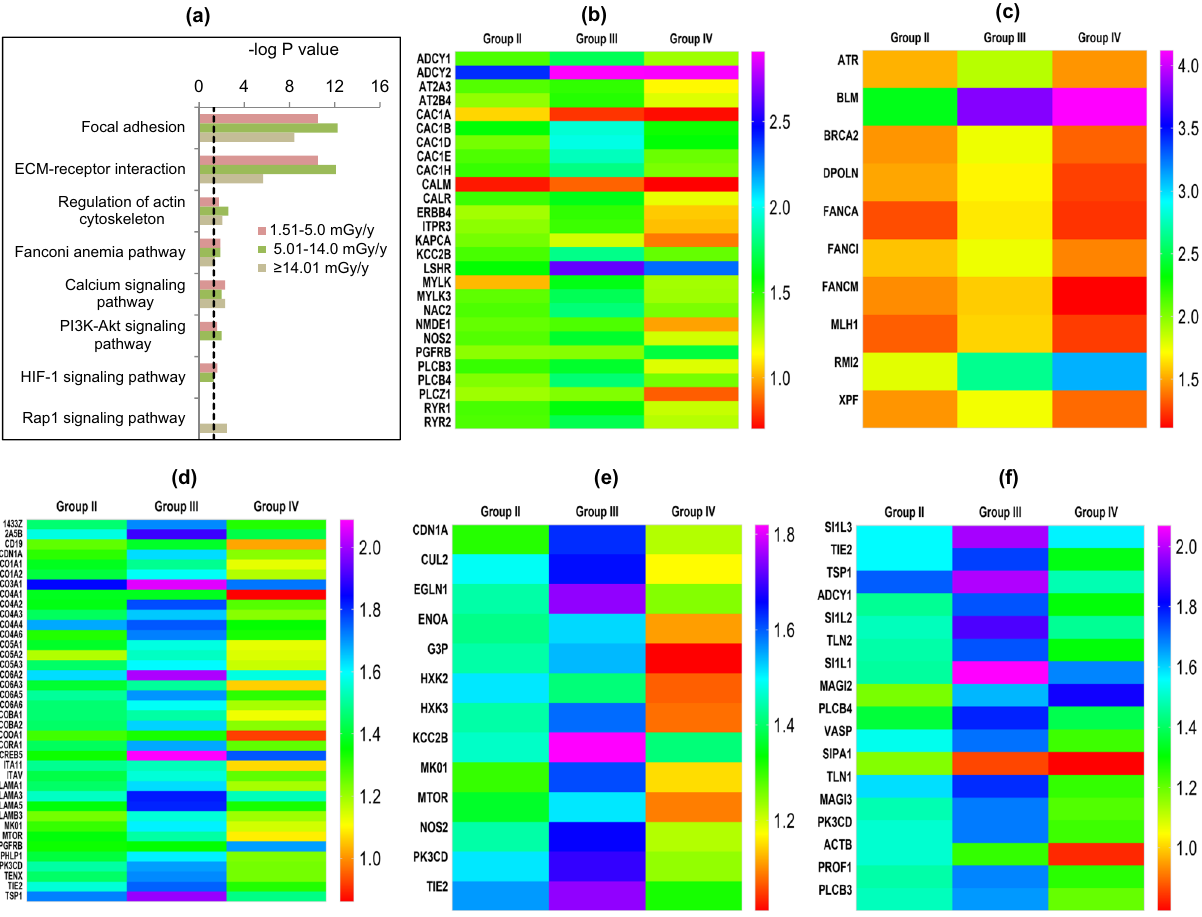
Figure 3. Pathway enrichment analysis of differentially regulated proteins in the three HLNRA dose groups relative to NLNRA dose group. ( a ) Enrichment of selected KEGG pathways (https ://www.kegg.jp/kegg/). The dotted line represents significant enrichment degree cut-off [− log10 (0.05), Fisher’s exact test] of each GO term. Representative heat maps for expression level of individual proteins of selected KEGG pathways. ( b ) Calcium signaling pathway, ( c ) Fanconi anemia pathway, ( d ) PI3-Akt signaling pathway, ( e ) HIF signaling, ( f ) Rap1